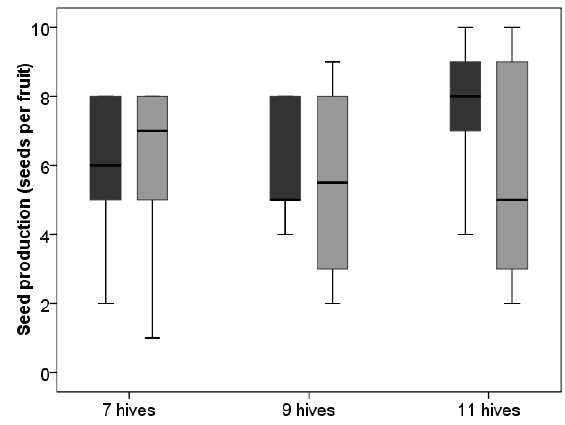
F IGURE 3. Number of seeds per fruit (seed production) from Eva trees in 2011 in relation to the number of Africanised honeybee hives ha -1 without pollen collectors (dark grey bar) and with pollen collectors (light grey